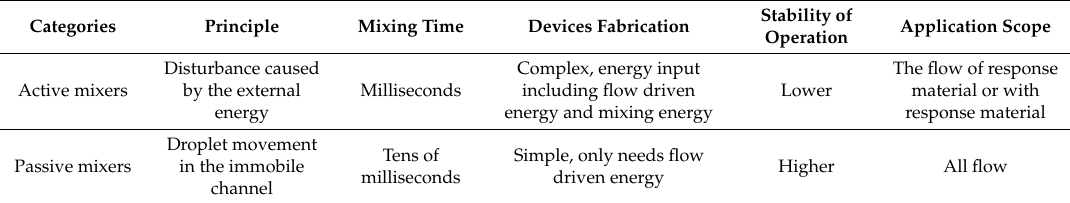
Table 1. Comparison of active and passive